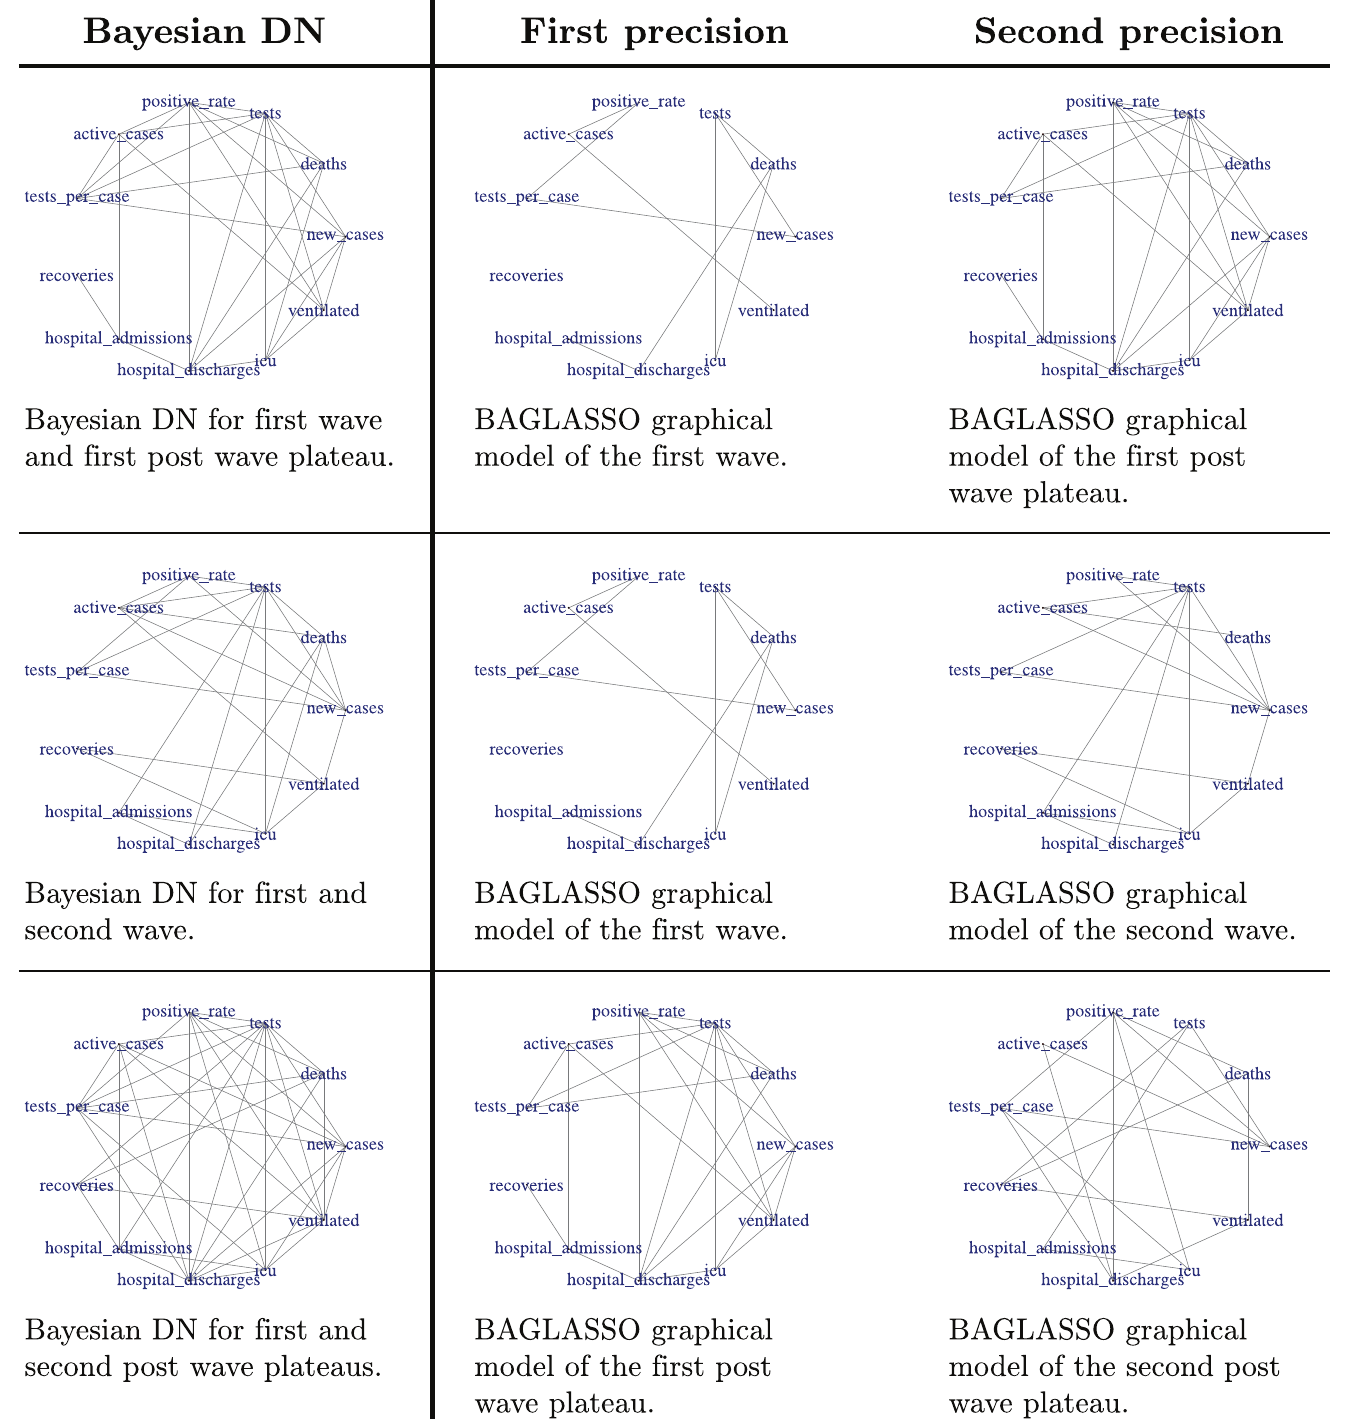
Fig 6. Bayesian DN estimates of South African COVID-19 data. The Bayesian DN and corresponding BAGLASSO graphical models between the first two waves; the first wave and the following plateau and finally the difference between the first and second post wave plateaus. The p − values from the Box’s M-test for homogeneity of covariance matrices between the contributing precision matrices were all less than 0.001 [43].